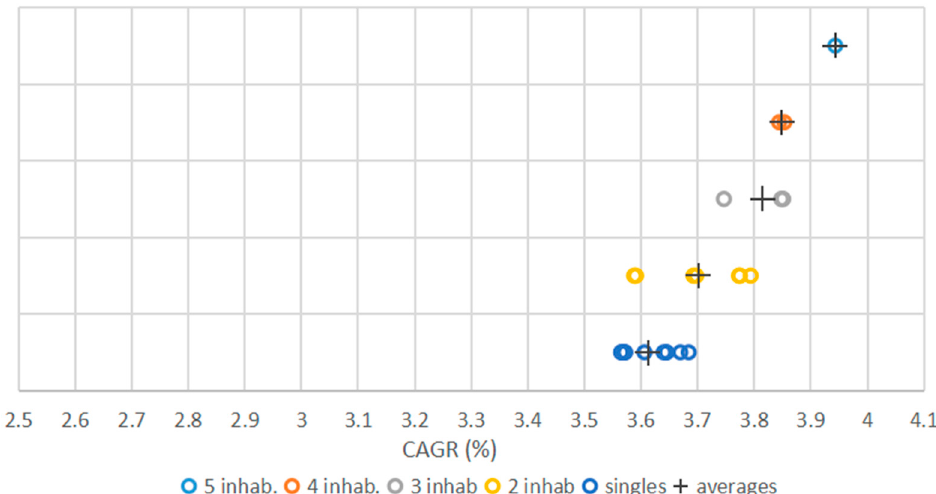
Figure A1. Relation between annual cumulative energy demand and cumulative energy received from the shared system for Scenario 1.